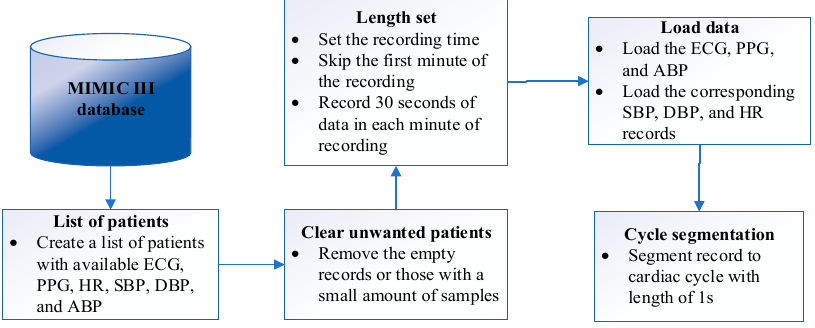
Figure 1. The steps to collect data for each